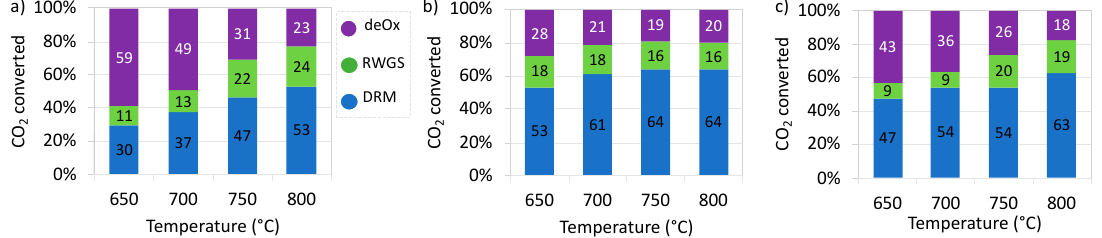
Figure 12. Contribution of DRM, reverse water-gas shift (RWGS) and CO 2 deoxidation (deOx) in CO 2 conversion during catalytic tests of DRM in isothermal conditions over Pt-CZ/CFF ( a ), Ni-CZ/CFF ( b ) and Pt-Ni-CZ/CFF ( c ). Reaction mixture: 4 vol. % CH 4 , 10 vol. % CO 2 , balanced with Ar. GHSV = 5000 h − 1 . TOS = 2 h.